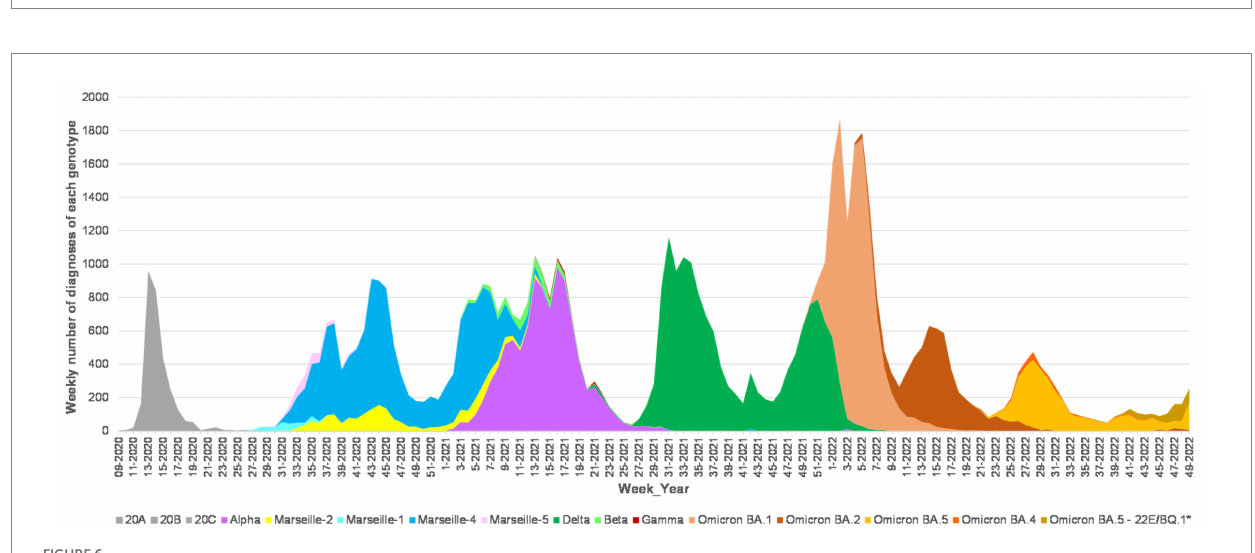
FIGURE 6 Weekly incidence of each major SARS-CoV-2 mutant and variant based on the genotyping performed at IHU Méditerranée Infection institute. SARS- CoV-2 genotyping was performed as previously described (Colson et al., 2022). Correspondence between genotype labels: Marseille-1: Pangolin lineage (Rambaut et al., 2020) B.1.416; Marseille-2: B.1.177; Marseille-4: B.1.160; and Marseille-5: